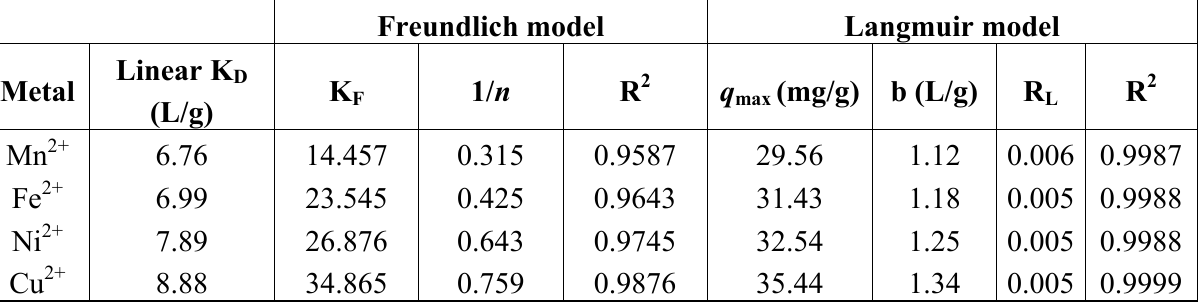
Table 4. Isotherm parameters of Mn 2+ , Fe 2+ ,Ni 2+ and Cu 2 adsorption on cow bone